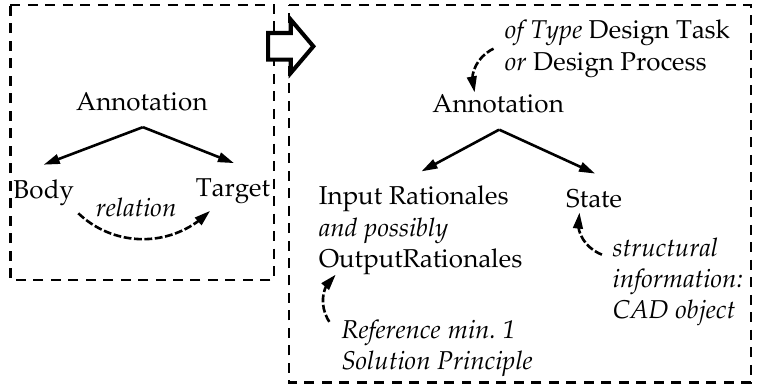
Figure 4. Web Annotation Data Model ( left ) and transferred Annotation Model for SeEDMC ( right ).